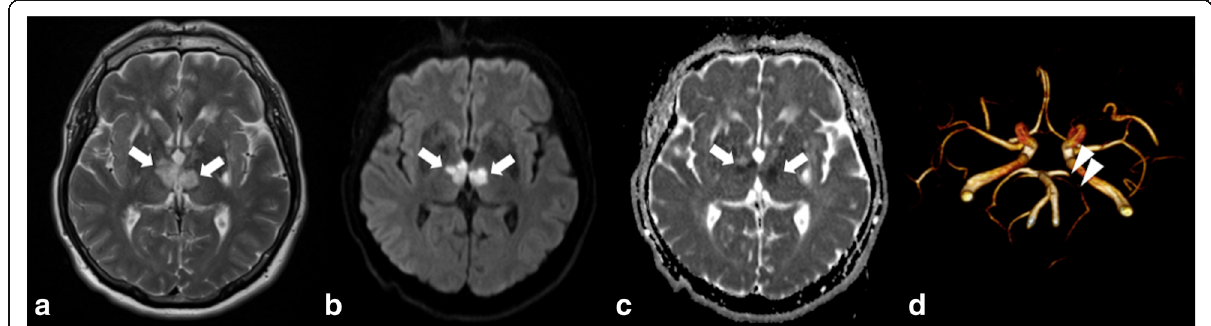
Fig. 11 High signal intensity of both thalami (arrows in a ) associated with diffusion restriction in the same area (arrows in b and c ) consistent with ischaemia due to occlusion of the artery of Percheron (anatomic variant). 3D TOF shows stenosis of the P1 segment of the left posterior cerebral artery (arrowheads in d ). The Percheron artery itself is not